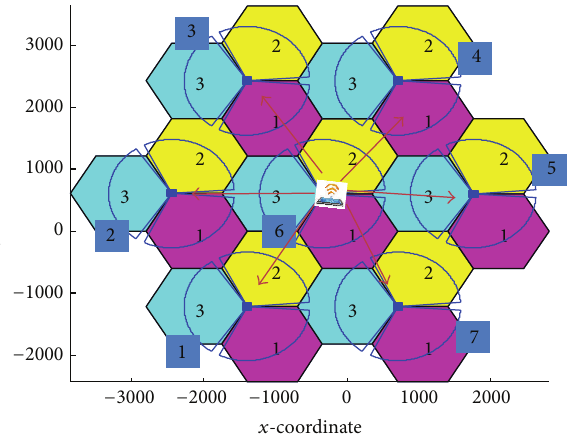
Figure 2: Potential movements of the